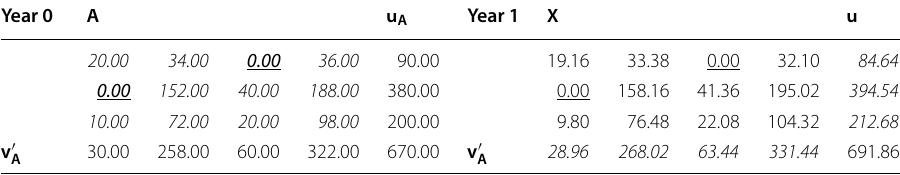
Table 6 Initial matrix with zero entries and the target marginal totals Year 0